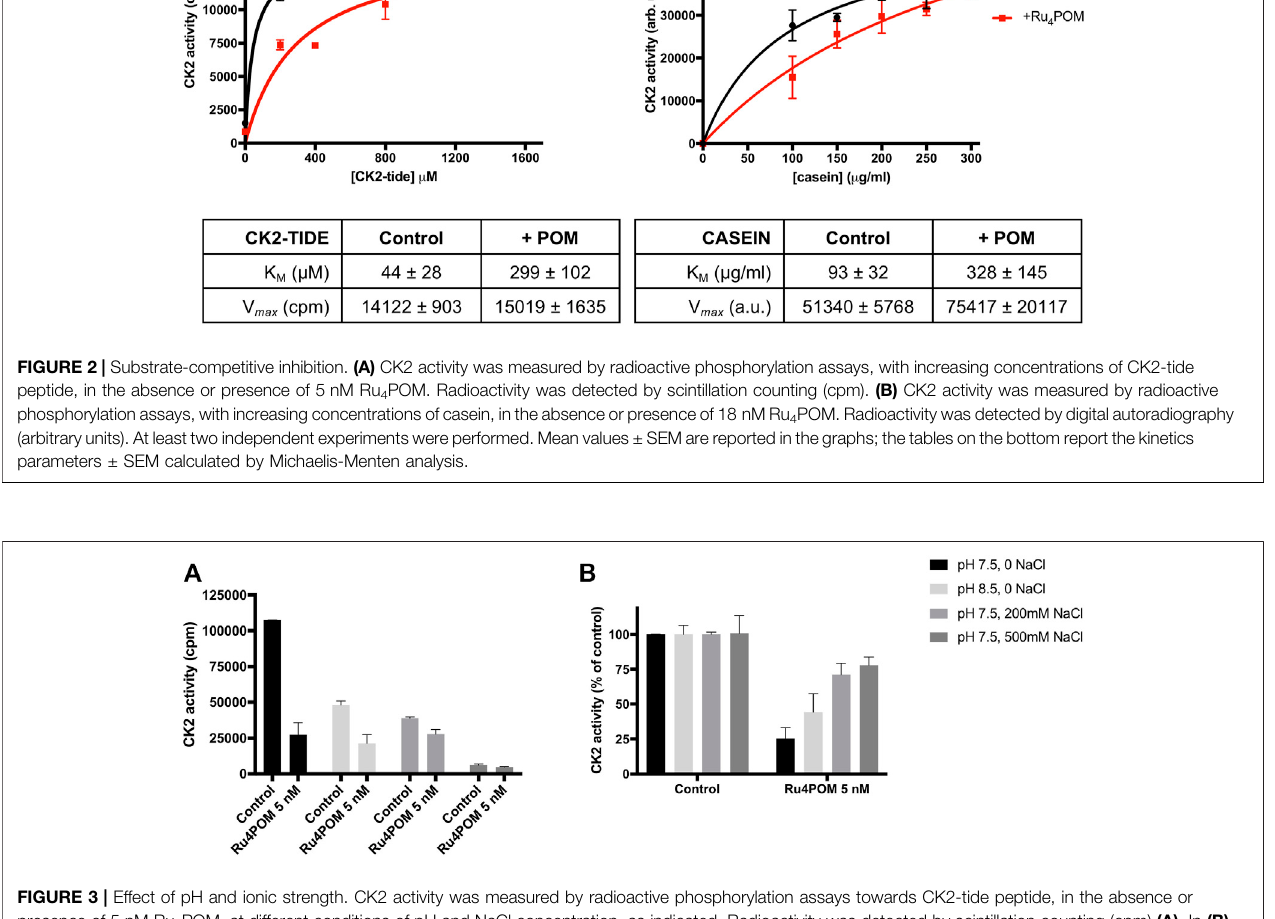
Frontiers in Molecular Biosciences |